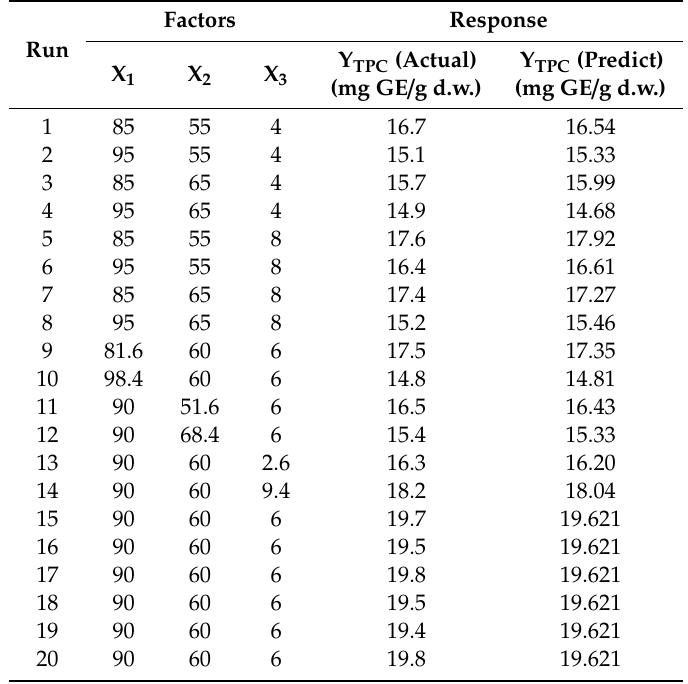
Table 3. Central composite design of actual factors and responses based on actual and predicted values.